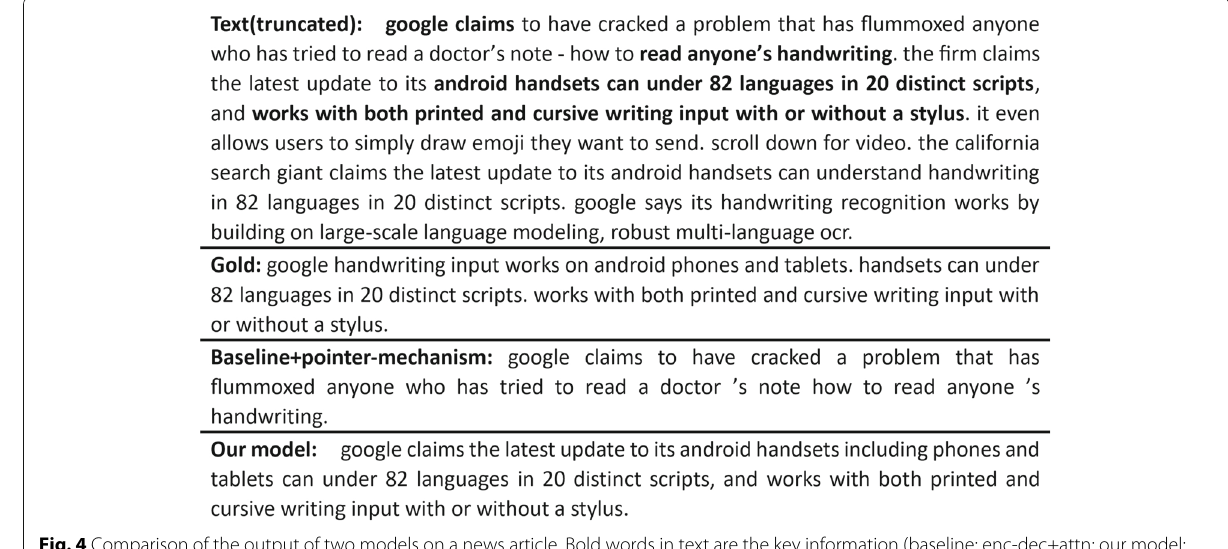
Fig. 4 Comparison of the output of two models on a news article. Bold words in text are the key information (baseline: enc-dec+attn; our model: